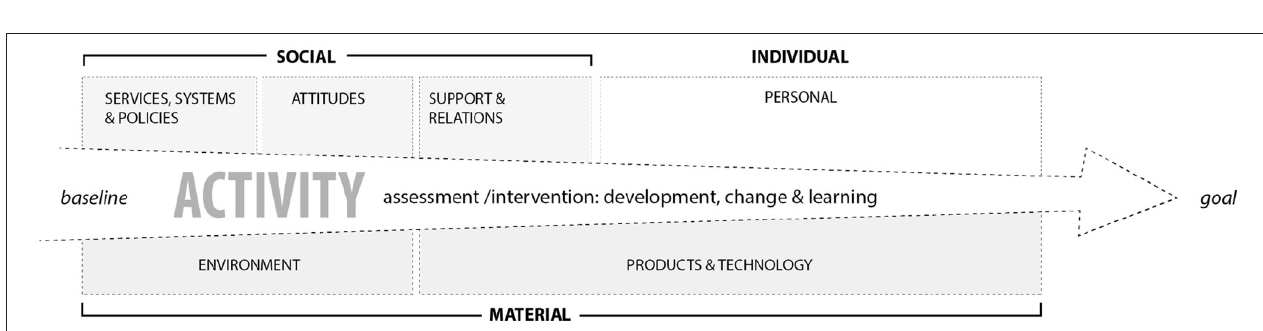
FIGURE 4 | Mapping of the trajectory of the implicit and explicit sequences of the assessment in the lighting lab placed in relation to extended ICF categories.